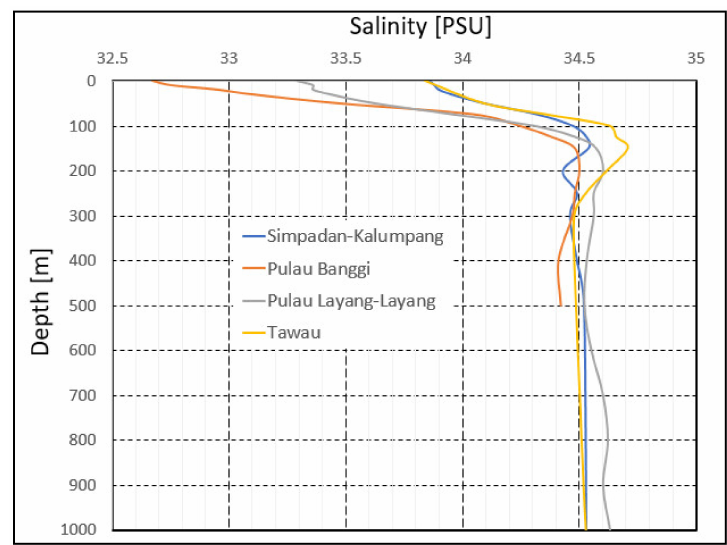
Figure 4. Deep seawater salinity (in PSU) and depth profile of Tawau, Sipadan, Pulau Kalumpang, Pulau Layang-layang and Pulau Banggi; data obtained from the online Japan Oceanographic Data Center